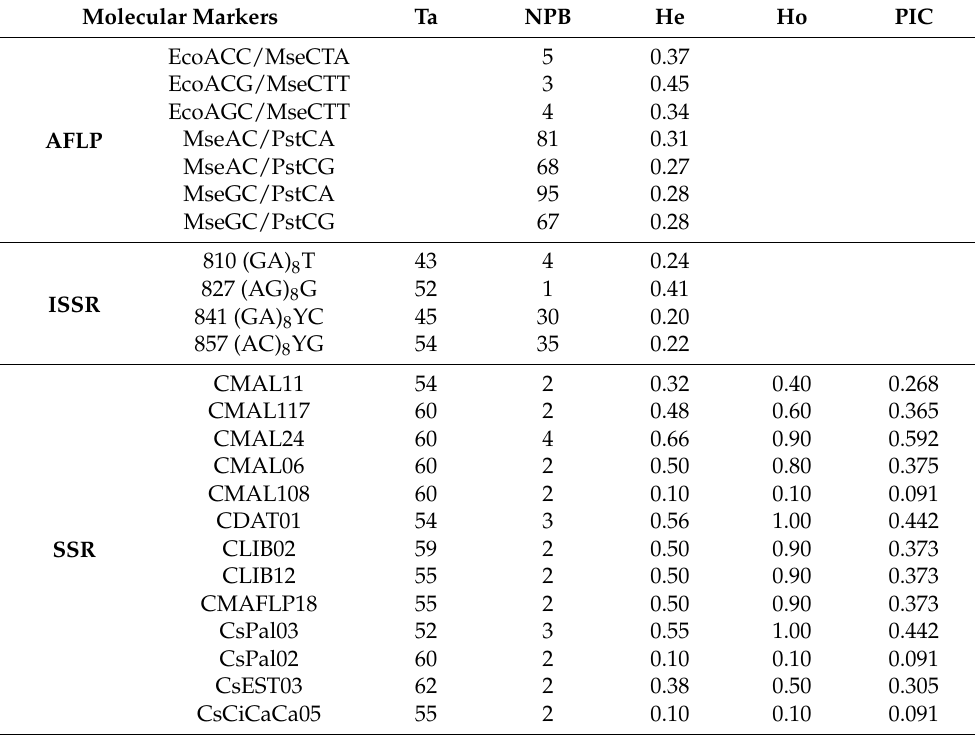
Table 2. ISSR, AFLP, and SSR used for germplasm